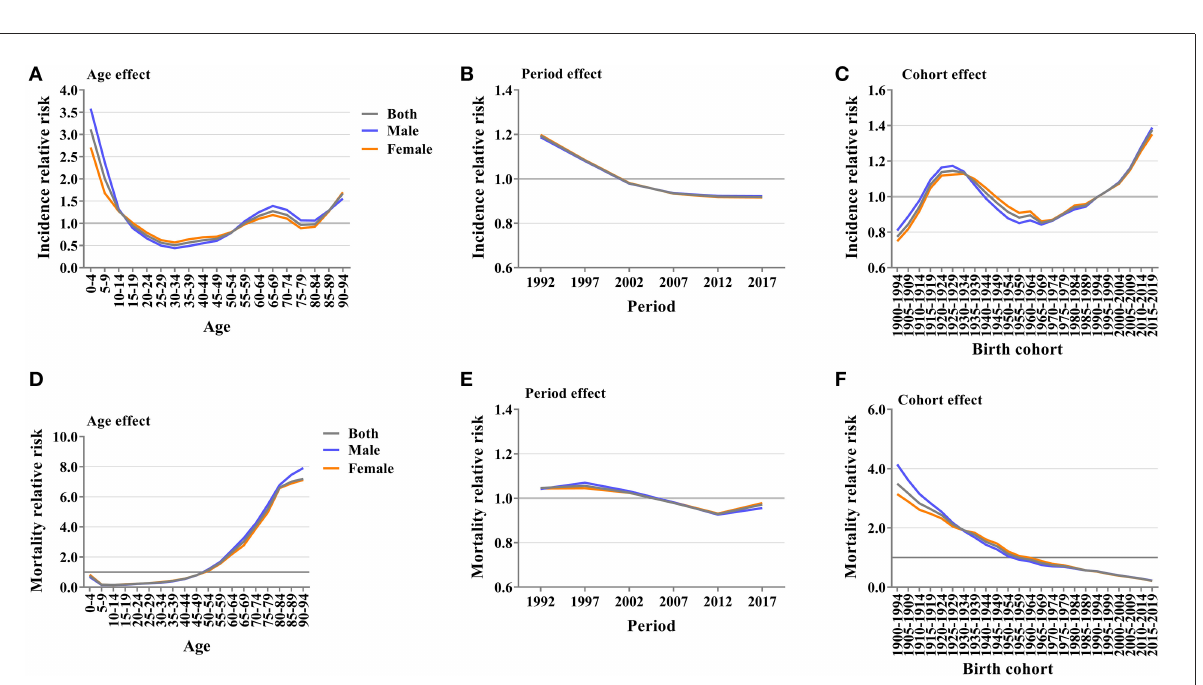
FIGURE6 Relative risk of asthma incidence and mortality. (A) Relative risk of asthma incidence due to age effect. (B) Relative risk of asthma incidence due to period effect. (C) Relative risk of asthma incidence due to birth cohort effect. (D) Relative risk of asthma mortality due to age effect. (E) Relative risk of asthma mortality due to period effect. (F) Relative risk of asthma mortality due to birth cohort